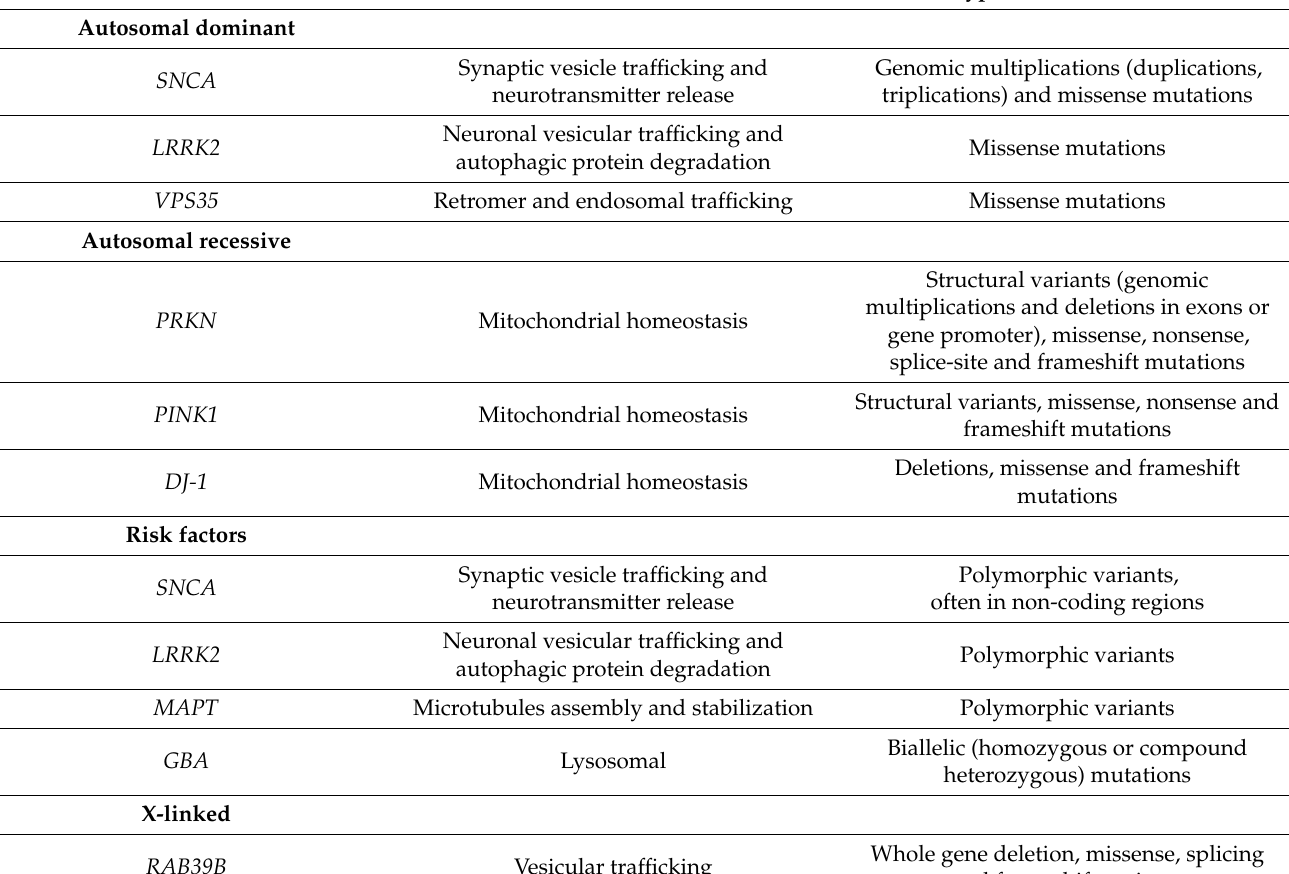
Table 1. Established Parkinson’s disease-causing genes and risk